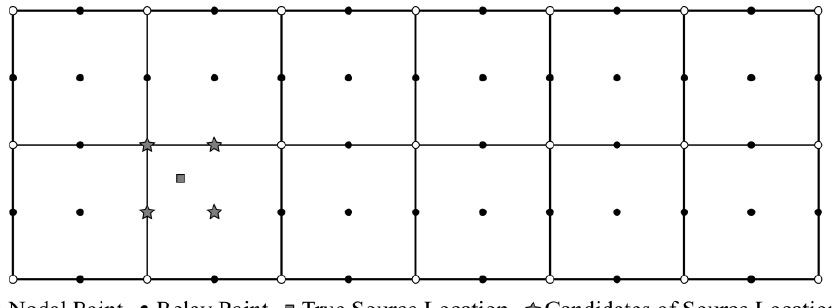
Figure 3. An example of an identified source location on a two-dimensional